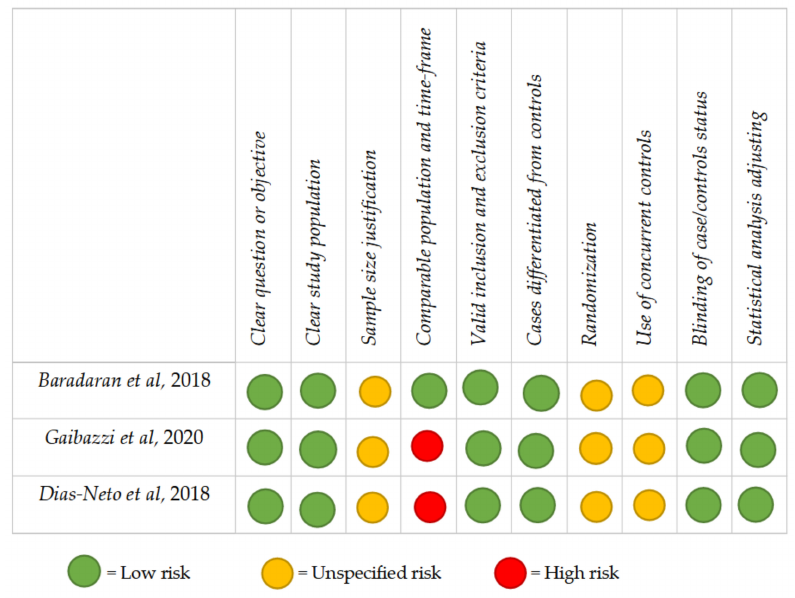
Figure 2. Critical appraisal, including the main potential risk of bias and quality score. Table 2. General characteristics of the selected papers, the results, and their statistical